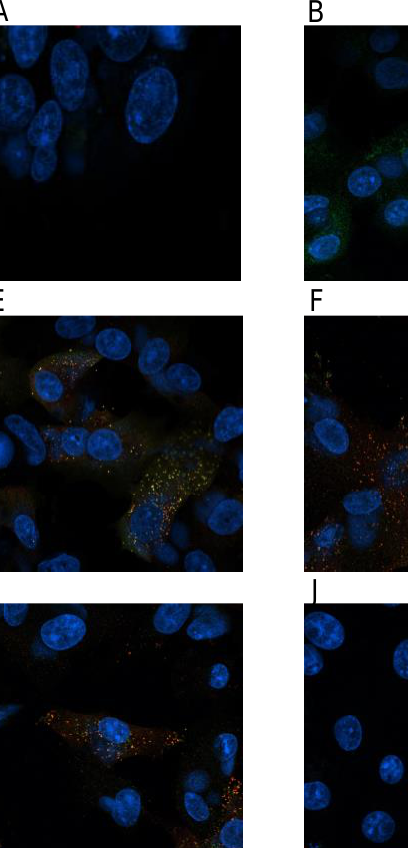
Figure 8. Confocal microscopy results of the scFv 3E2 ( A ), the mAb 15B6 ( B ), the mAb 5B4/2F2 ( C ), an anti-envelope rabbit immune serum ( D ), a mixture of the scFv 3E2 and the mAb 5B4/2F2 ( E ), a mixture of the mAbs 15B6 and 5B4/2F2 ( F ), a mixture of the scFv 3E2 and the mAb 15B6 ( G ), a mixture of scFv 3E2 and rabbit anti-envelope serum ( H ) and a mixture of mAb 15B6 and rabbit anti-envelope serum ( I ). All were able to penetrate the cell through permeabilisation to different extents. ( J ) is the negative control without VACV infection.